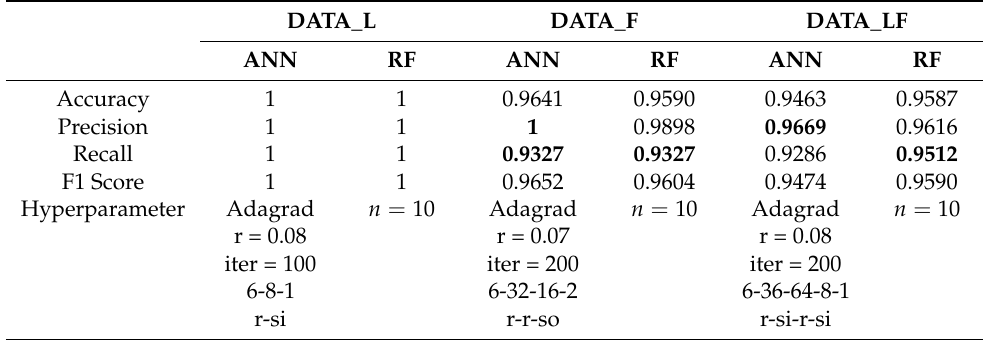
Table 15. Experimental results of abnormal data